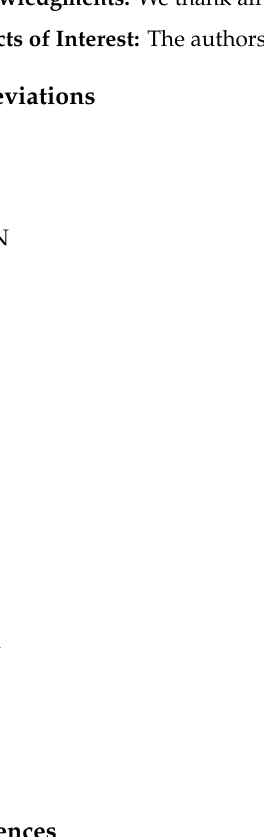
Table S1: The list of antibodies. Table S2: The list of cell lines